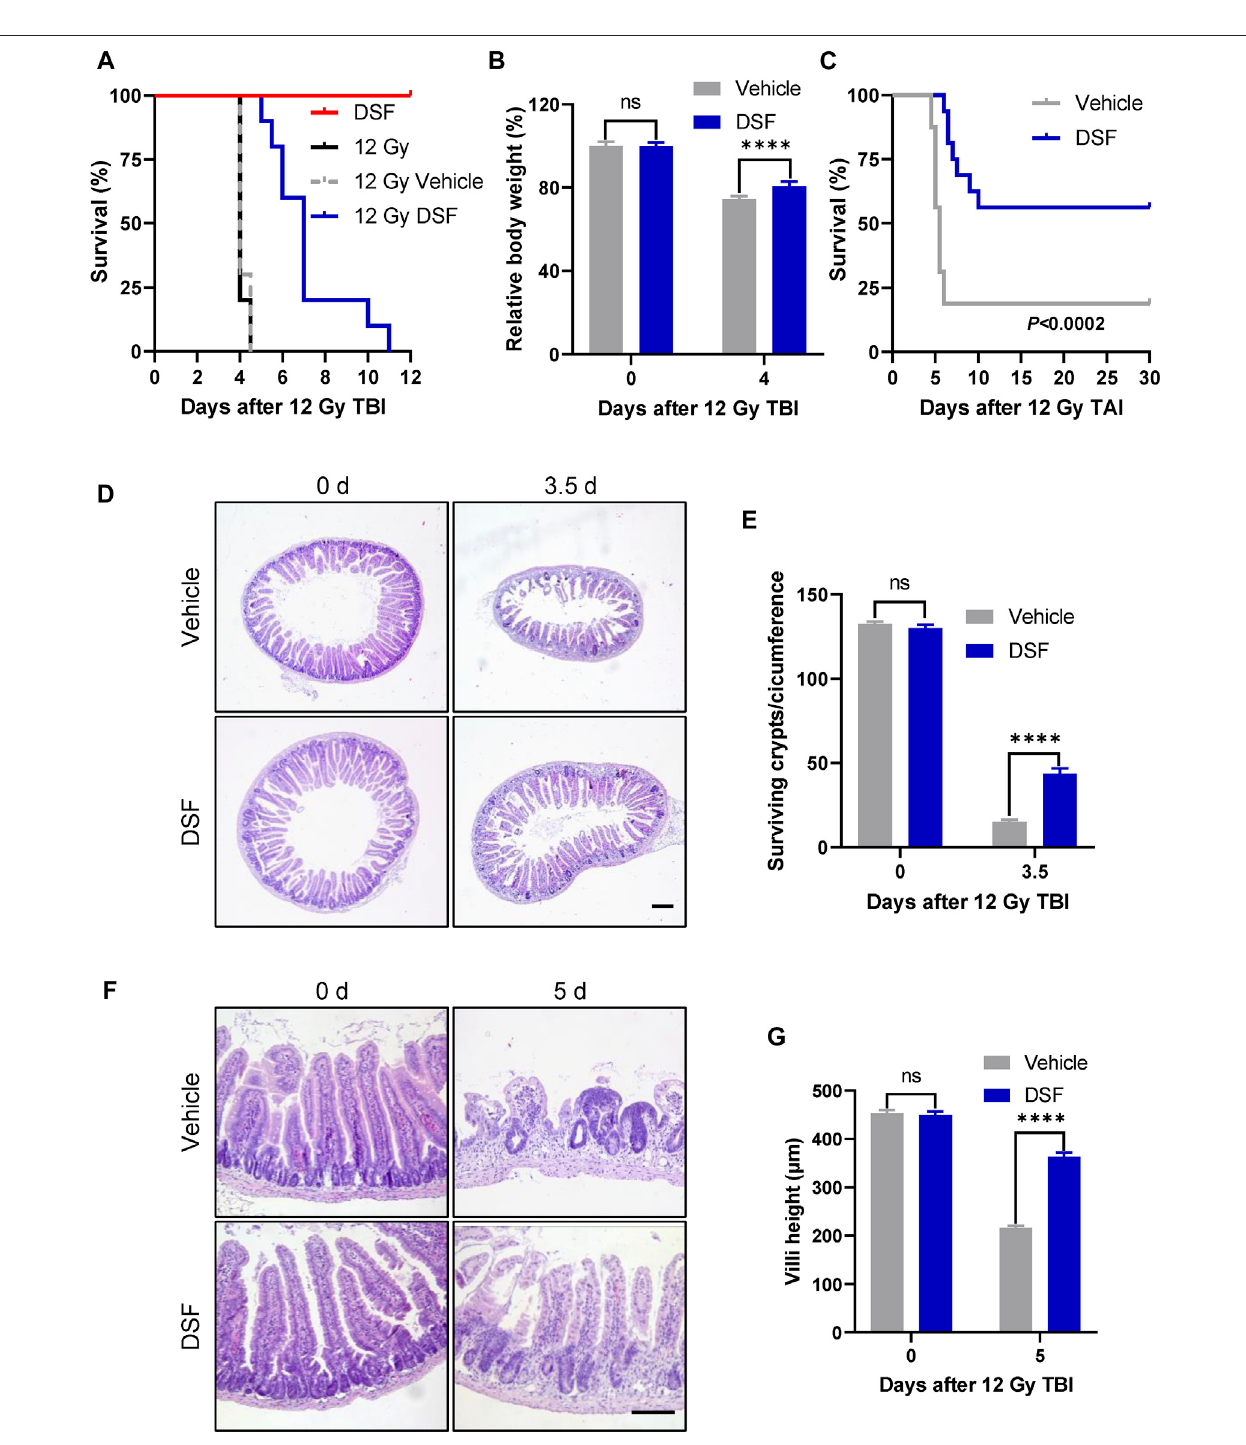
FIGURE 1 | DSF protects against irradiation-induced lethal intestinal injury. Mice were intraperitoneal injected with 100 mg/kg DSF or vehicle (5% DMSO and 5% Tween-80 and 90% saline) 1 h prior to 12 Gy irradiation. (A) Survival curves of no treatment, vehicle, DSF- treated C57BL/6J mice ( n = 10) after 12 Gy TBI and DSF- treated C57BL/6J mice ( n = 10) without radiation. p < 0.0001, vehicle versus DSF treatment after 12 Gy TBI, by unpaired, two-tailed Student ’ s t-test. (B) Relative body weight on 4 days after TBI. (C) Survival curves of vehicle or DSF-treated C57BL/6J mice (n = 16) after 12 Gy of TAI. (D) Representative images of H&E-stained intestinal sections with the indicated treatment at 3.5 days. Scale bars = 200 μ m. (E) Quantitative analysis of surviving crypts in (D) . (F) Representative images of H&E- stainedintestinalsectionswiththeindicatedtreatmentat5 days.Scalebar=100 μ m. (G) Quantitativeanalysisvillusheightin (F) .Valuesaremeans±SEM; n =3-4mice in each group. **** p < 0.0001, vehicle versus DSF treatment, by unpaired, two-tailed Student ’ s t-test. DSF, disul fi ram; TAI, total abdominal irradiation; TBI, total-body irradiation.